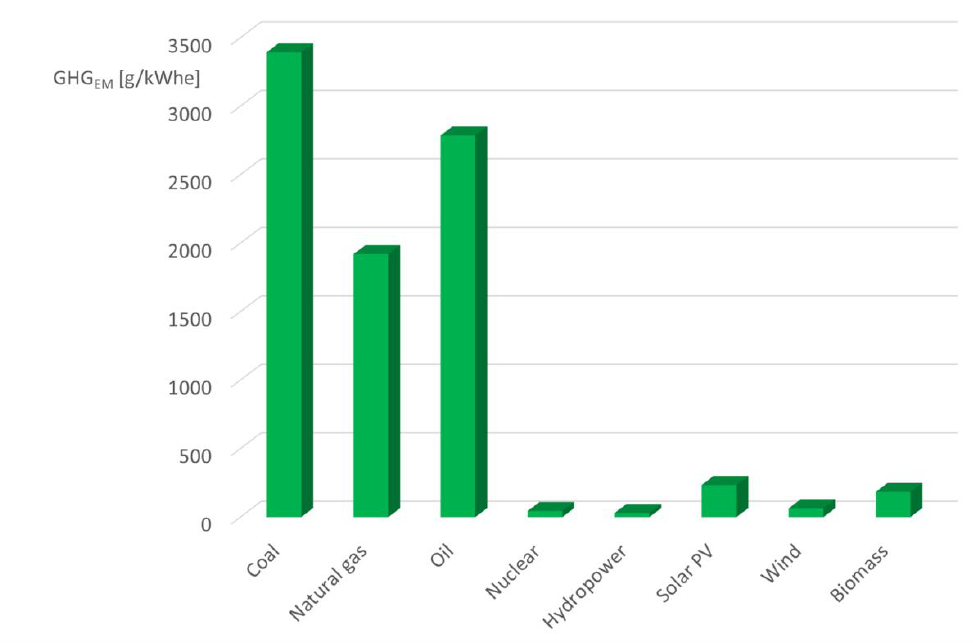
Figure 13. GHG emission of BEV for electricity produced by several energy sources. 3.1. Energy Vectors Cost Table 3 shows the comparison between the energy vector cost of the five vehicles considering the four sections of the path considered we have, calculated considering average prices (including taxes) of petrol, gasoline [26], and electricity [27] in Italy in 2019: 